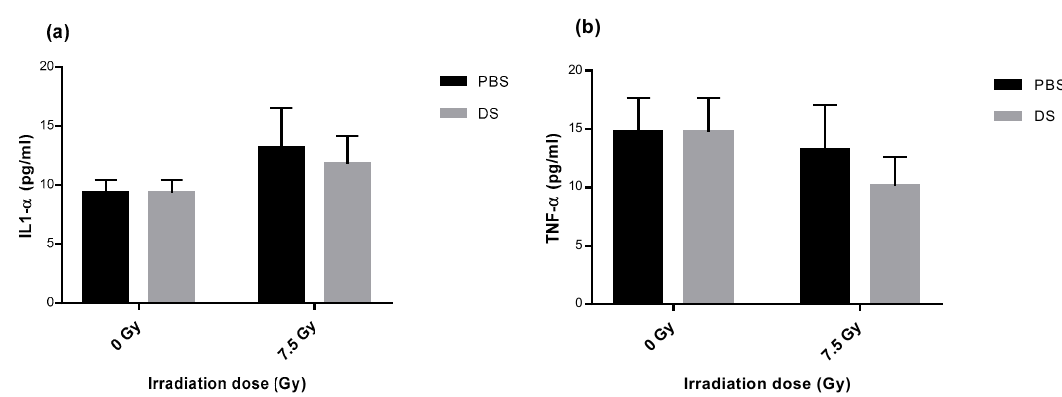
Figure 3. IL-1 α ( a ) and TNF- α ( b ) concentration in plasma of mice irradiated by PBS or DS proton beams in the plateau phase of the Bragg peak. Data are depicted as mean values ± SEM. Each experiment was performed in triplicates.